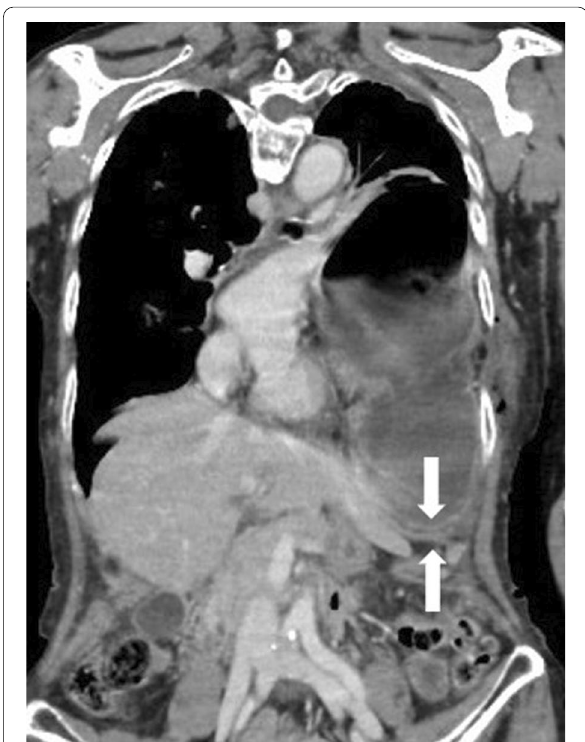
Fig. 2 Diagnosis of tension gastrothorax. Computed tomography showed prolapse of the stomach into the thoracic cavity and compression of the left thoracic cavity. The two-layered structure of the gastric wall and diaphragm indicated gastrothorax